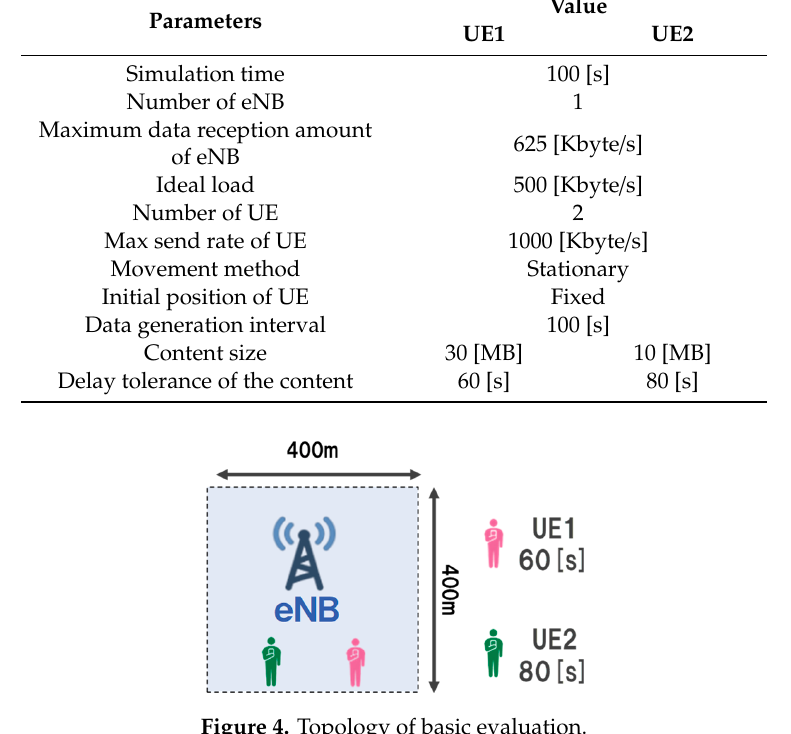
Figure 4. Topology of basic evaluation.